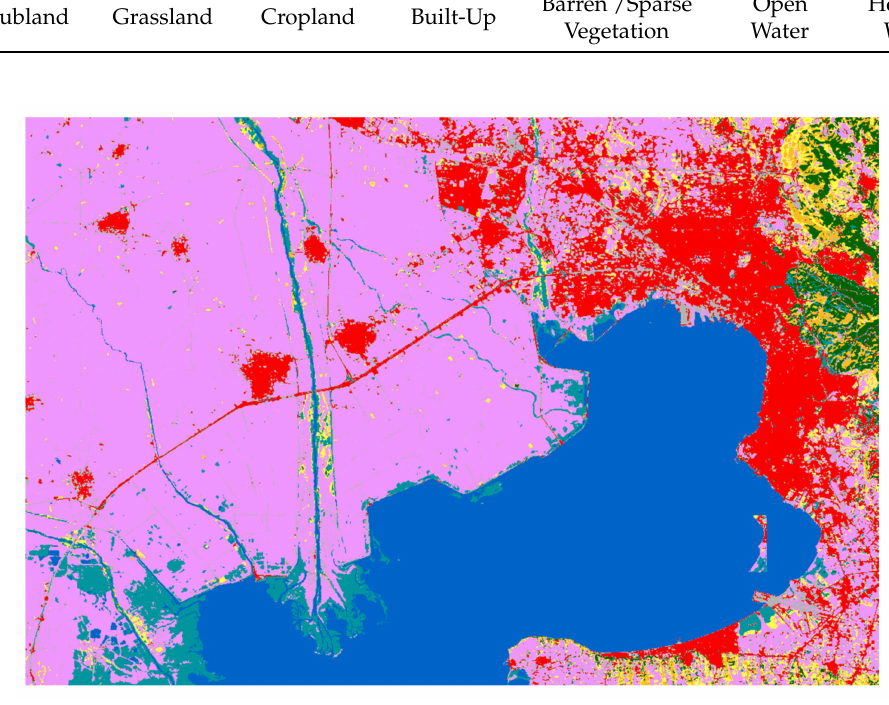
Figure 10. Land Cover Classification with U-Net using the colour coding of Table 1.